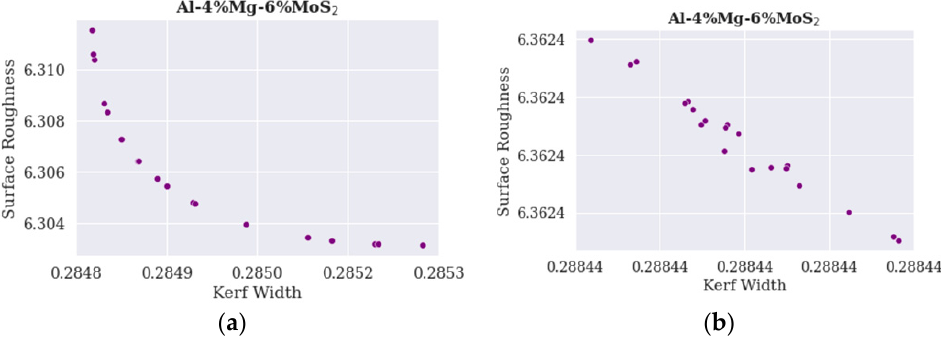
pulse on time of 57 µs, and gap voltage of 31 V. time of 57 µs, and gap voltage of 31 V.